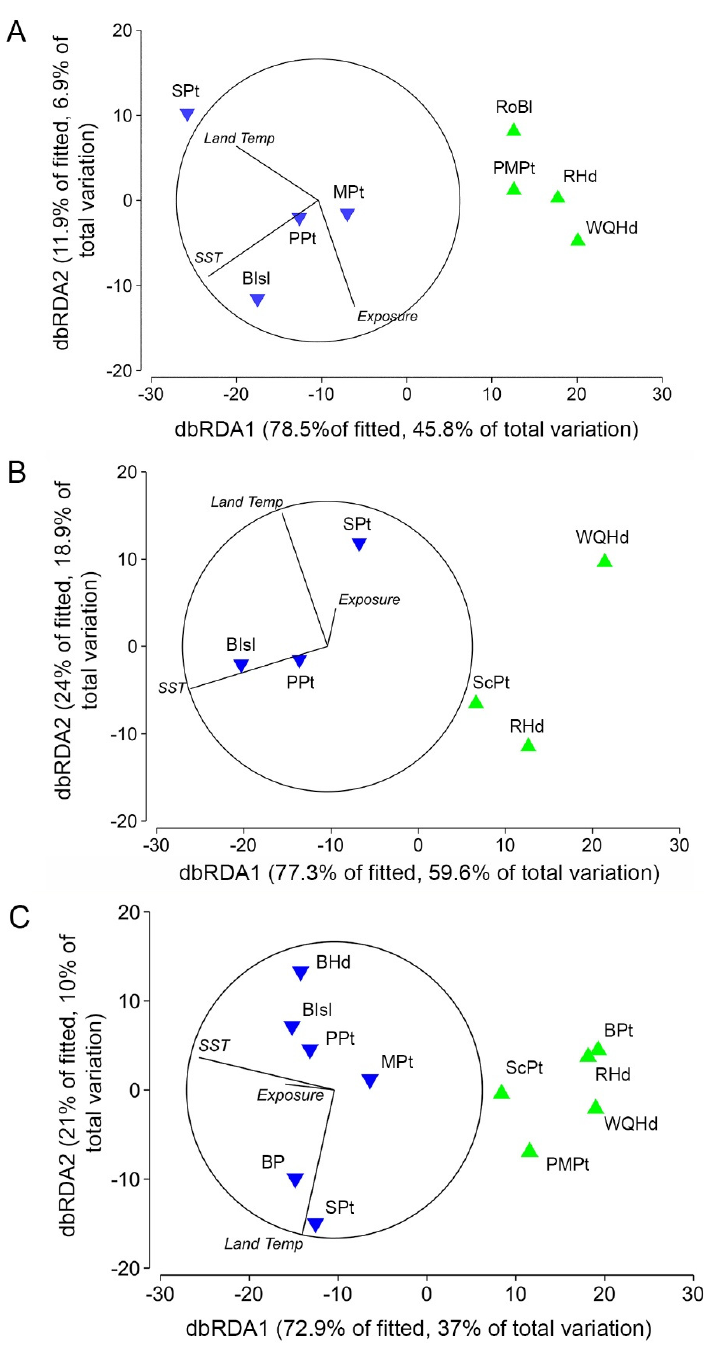
Figure 8. dbRDA of the modelled species assemblage similarity data with the predictor variables land temperature, SST, and exposure. Vectors show the strength and direction of the effect each variable had in relation to the others in constructing the ordinations. ( A ) 2004; ( B ) 2007; ( C ) 2012. Symbology: Blue triangles, southern GoM region; green triangles, northern GoM region. Abbrevi-ations: BIsl, Bailey Island; BHd, Bald Head; BP, Biddeford Pool; BPt, Black Point; MPt, Marshall Point; PPt, Pemaquid Point; ScPt, Schoodic Point; SPt, Sea Point; PMPt, Petit Manan Point; RHd, Red Head; RoBl, Roque Bluffs; WQHd, West Quoddy Head.